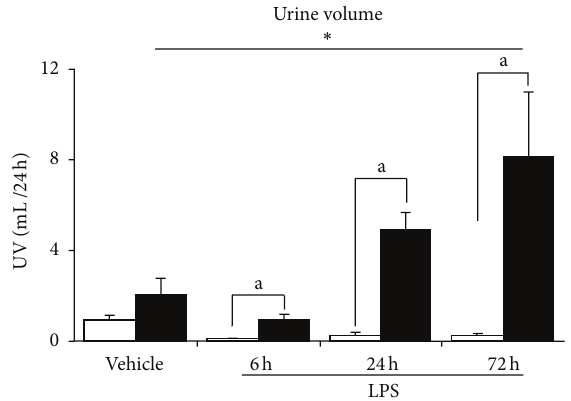
Figure 3: Urinary volume in diabetic (black bars) and nondiabetic (open bars) LPS-injected mice. Values are mean ± SEM. ∗ 𝑃 < 0.05 versus control value and a 𝑃 < 0.01 versus nondiabetic.